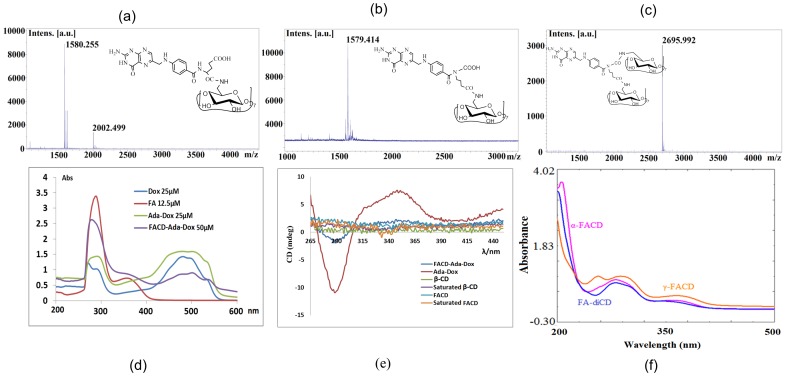
The HR-MALDI-TOF, UV, and circular dichroism spectra of Dox, Ada-Dox, FA, α- & γ-FACD, FA-diCD, and FACD-Ada-Dox.Plots a, b, & c show the MALDI-TOF spectra of α-FACD, γ-FACD and FA-diCD, respectively. Plot d shows the UV spectra of Dox, Ada-Dox, FA, and FACD-Ada-Dox in DMF. Plot e illustrates the circular dichroism spectra of Ada-Dox, β-CD, FACD and FACD-Ada-Dox in the far and near UV region in DMF at 20°C in the near and far UV (e). Plot f displays the UV spectra of α- & γ-FACD.